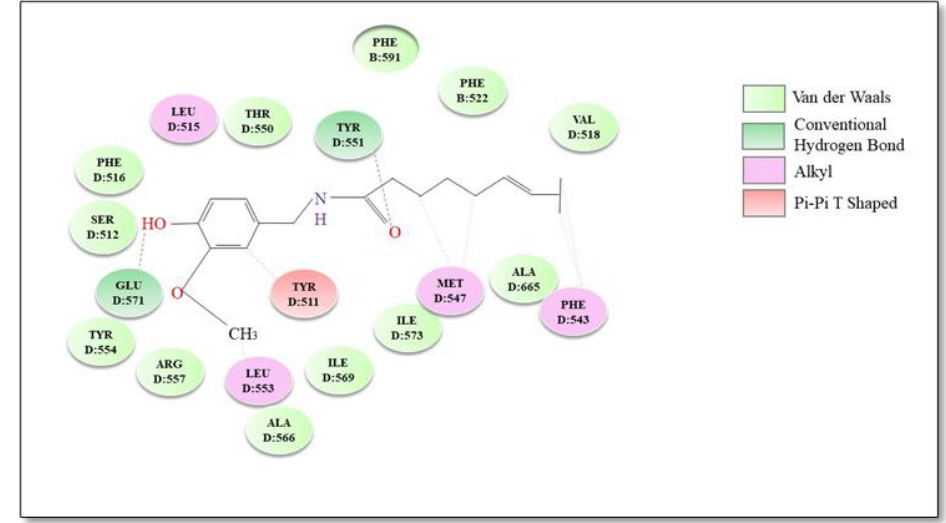
Figure 1. Molecular docking 2D diagram of capsaicin with TRPV1 receptor.